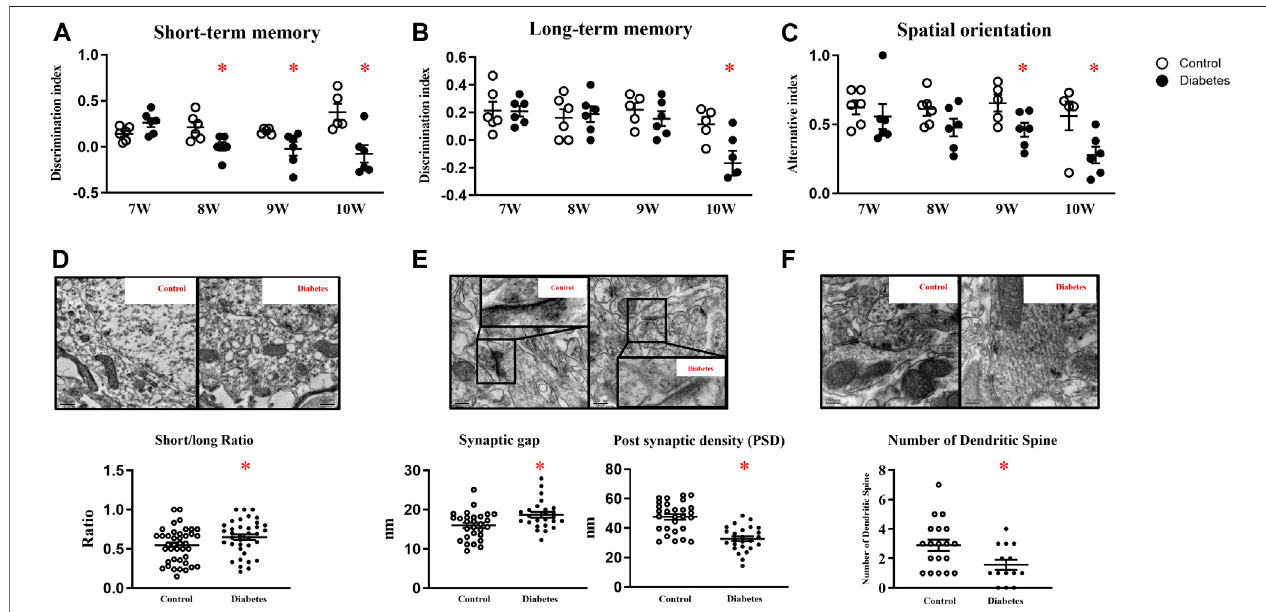
FIGURE1| Diabeticmiceexhibitcognitivede fi cits.Diabeticmiceexhibitlowerscoresinshort-termmemory (A) ,long-termmemory (B) ,andspatialorientationtests (C) . (D) Representative picture of mitochondria in hippocampal neurons (upper panel) and the ratio of short/long axis of mitochondria (40 mitochondria from control, 37 from diabetic mice, n = 3) (200,00 ×, Bar = 0.5 µm) (lower panel). (E) Representative picture of a synaptic gap (upper panel) in the hippocampus and measurement of synaptic gaps and PSD (lower panel) (28 synapses from control, 25 from diabetic mice, n = 3). (500,00 ×, Bar = 200 nm) (F) Representative picture of dendritic spines in the hippocampus (upper panel) and numbers of dendritic spines per dendrite (lower panel) (19 dendrites from control, 14 from diabetic mice, n = 3) (500,00 ×, Bar = 200 nm) Data presented as means ± SEM, * p < 0.05 vs